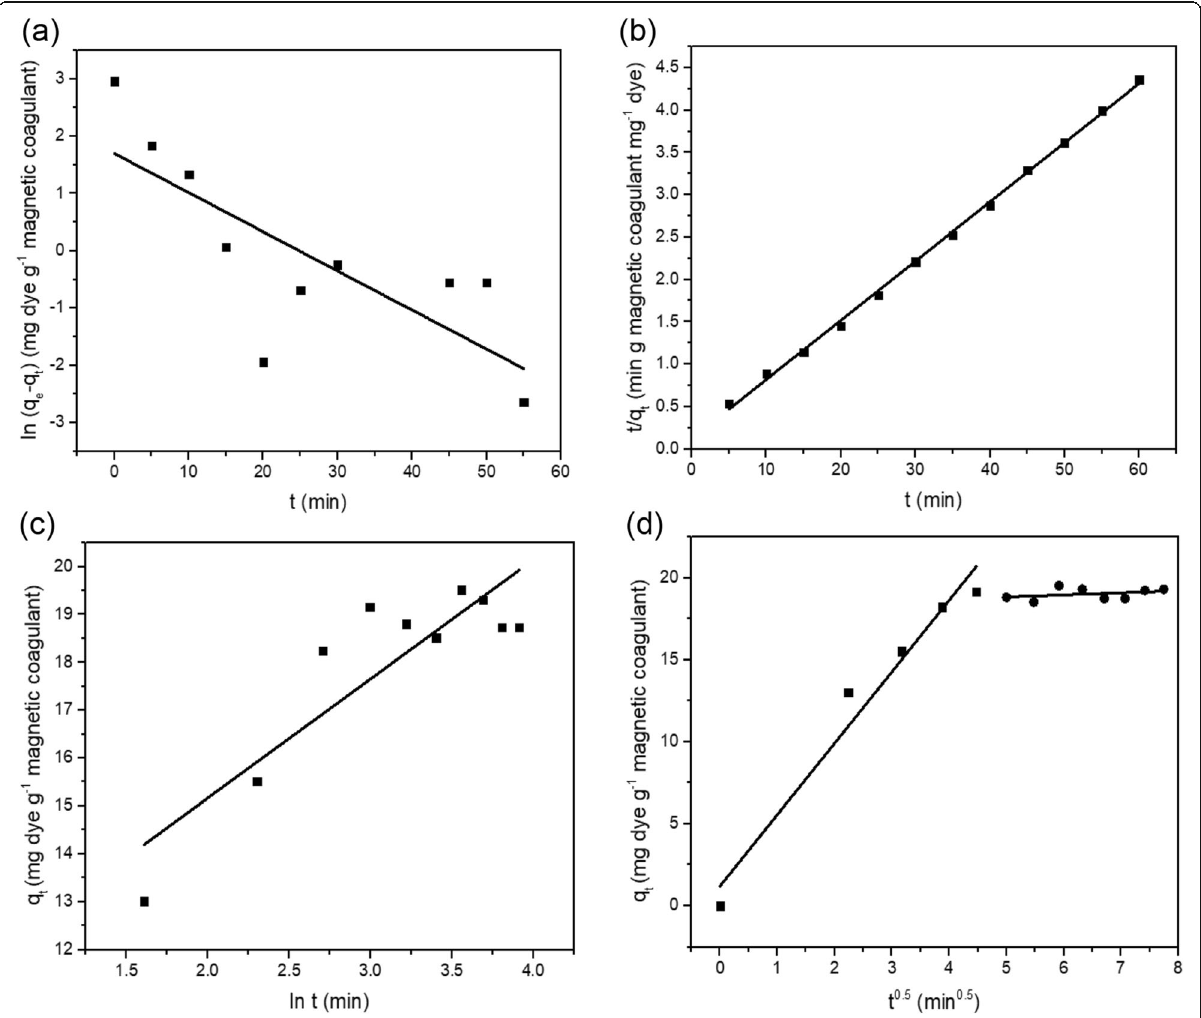
Fig. 6 Plots of pseudo 1st order ( a ), pseudo 2nd order ( b ), Elovich ( c ), and inter-particle diffusion ( d ) kinetic model (pH 3, magnetic coagulant dosage 420 mg L − 1